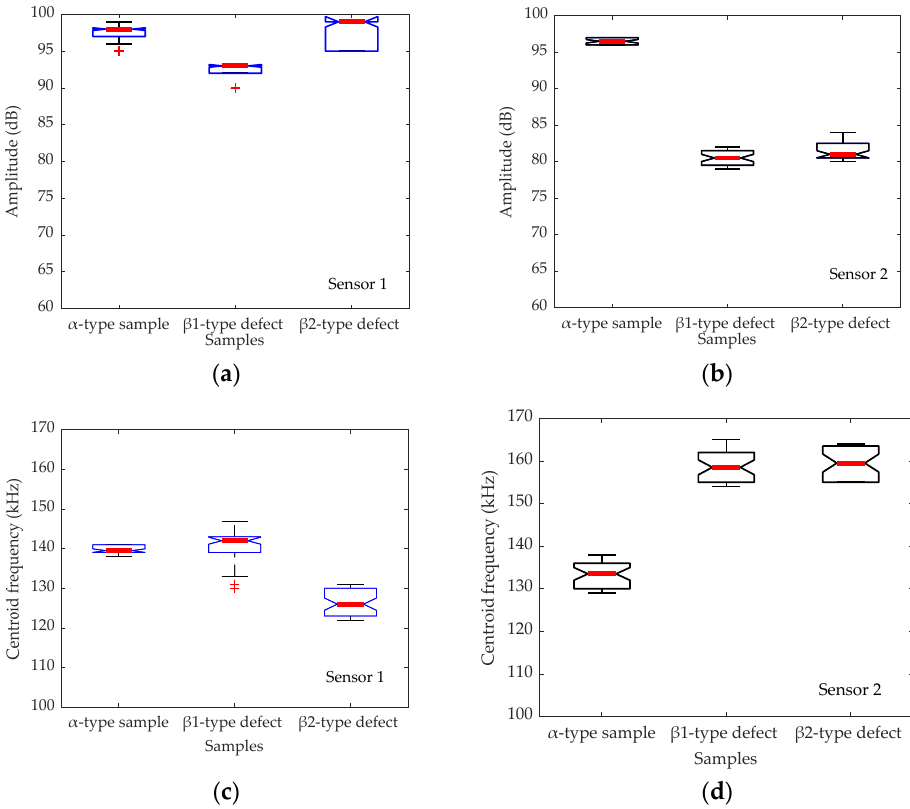
Figure 4. Experimental results. Amplitude ( a , b ) and centroid frequency ( c , d ) recorded by sensor 1 ( a , d ) and sensor 2 ( b , c ). (The “+” symbol indicates outliers).